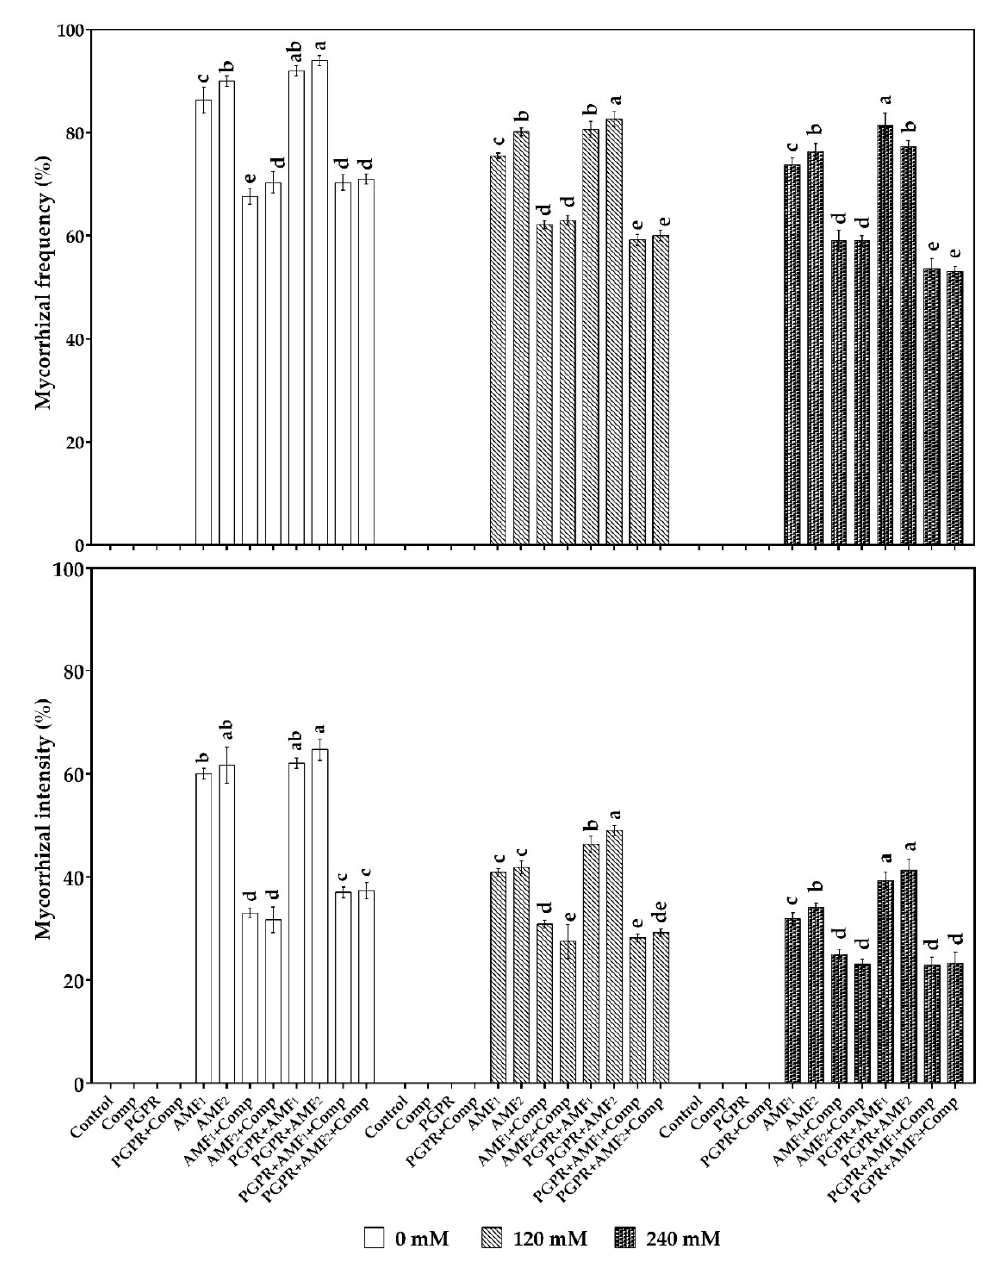
Figure 1. Effects of salt stress and biofertilizers on arbuscular mycorrhizal fungal (AMF) root colonization frequency and intensity of date palm vitroplants. Comp: compost; AMF 1 : native AMF consortium; AMF 2 : AMF pure strain; PGPR plant growth promoting rhizobacteria. Data presented are means ± standard deviations, n = 3. Bars followed by the same letters within the same salt stress level are not significantly different according to Student–Newman–Keuls test ( p < 0.05).